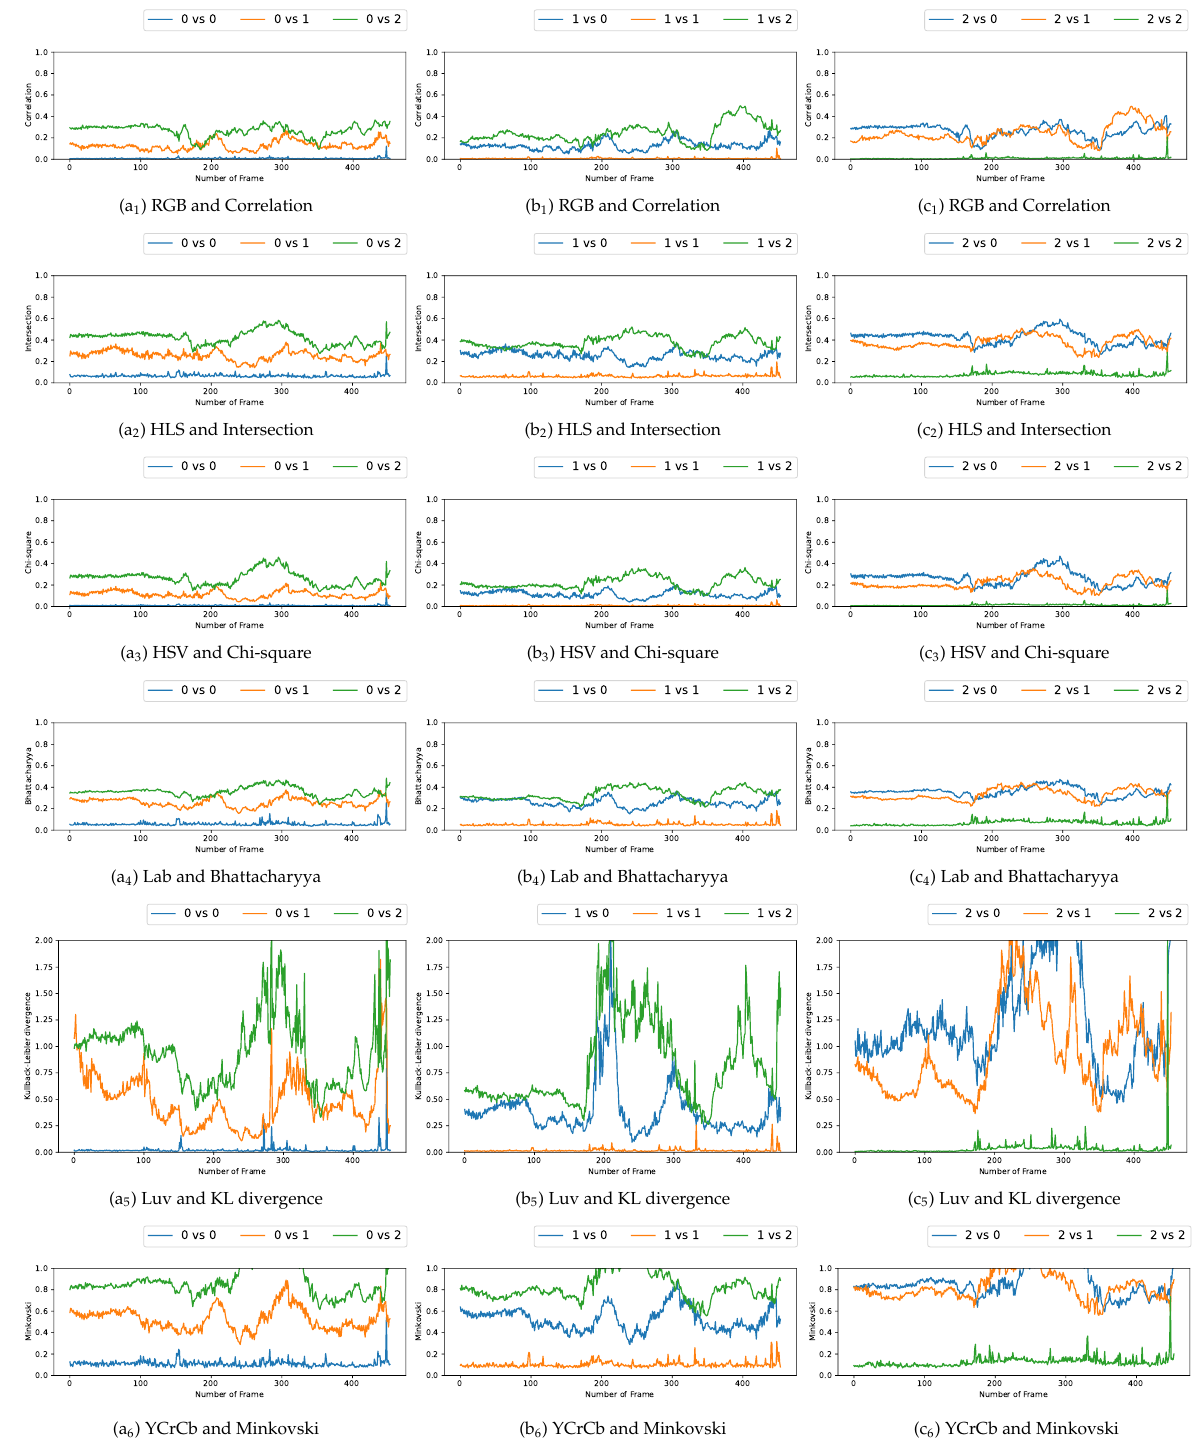
Figure 6. Curves comparing persons from one frame to another in video 2 (persons 0, 1 and